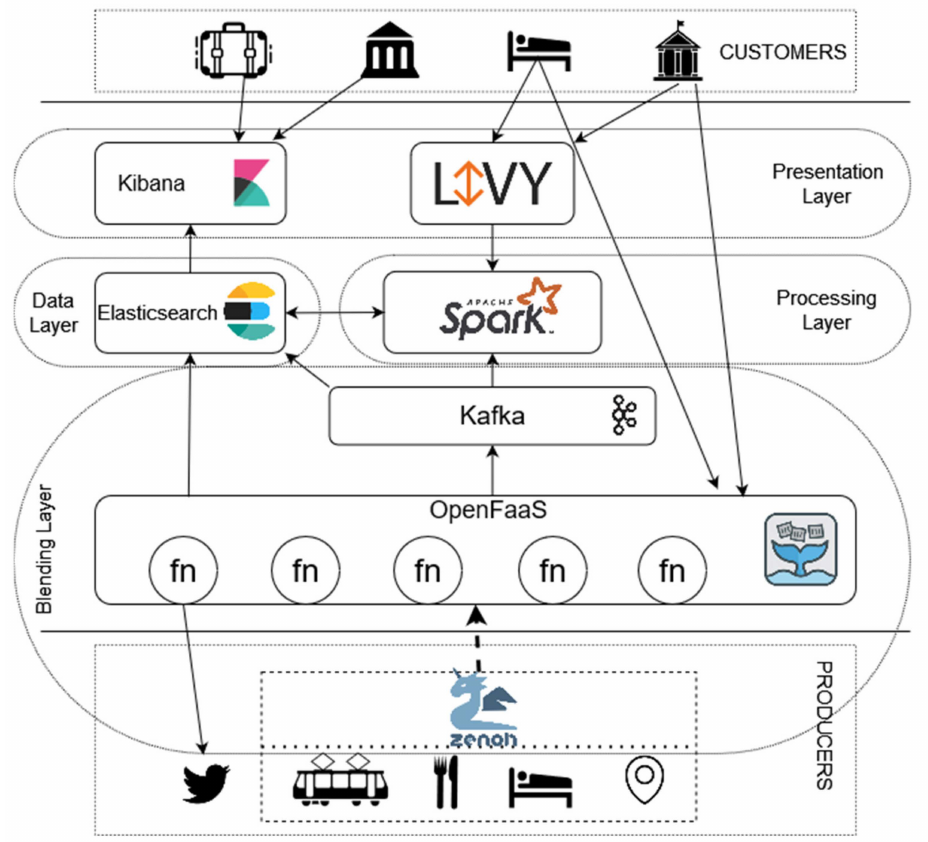
Figure 3. First prototype of APERTO 5.0 realized to satisfy pilgrims path